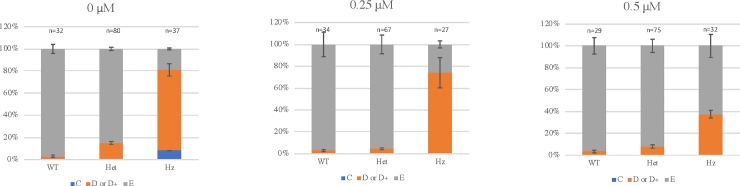
Phenotypic and genotypic analysis following treatment of incrossed heterozygous bmp4st72/+ zebrafish with 0 μM, 0.25 μM and 0.5 μM PTC124.Larvae were dechorionated at 6–8 hours post fertilization (hpf) prior to starting PTC124 treatment. Analysis was performed at 72 hpf and the results are shown as the mean of 3 independent experiments. Larvae were scored as wildtype (E), mild reduction/deformity in ventral tail fin (D+ or D) or severe reduction/deformity in ventral tail fin (C). WT = wildtype, het = heterozygote, HZ = homozygote. Error bars show standard error of the mean. We tested for trend in the probability of tail fin defects across the increasing doses of 0 μM, 0.25 μM and 0.5 μM PTC124 treated, groups of homozygous larvae [24]. The probability of tail fin defect decreased from 81.08% to 74.07% and 37.50% as the dose increased to 0.25 μM and 0.5 μM. The decreasing trend was statistically significant (p = 0.0002).